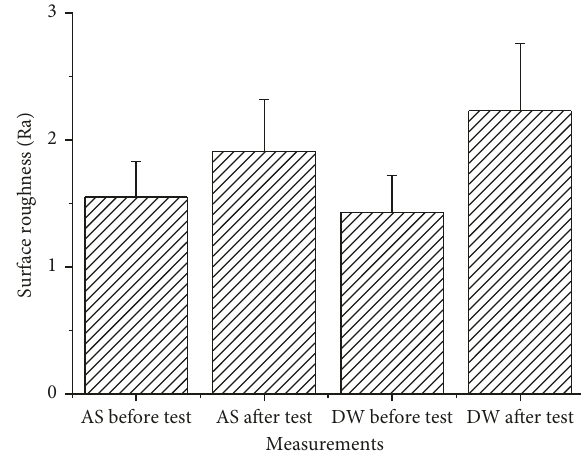
Figure 14: Surface roughness of the